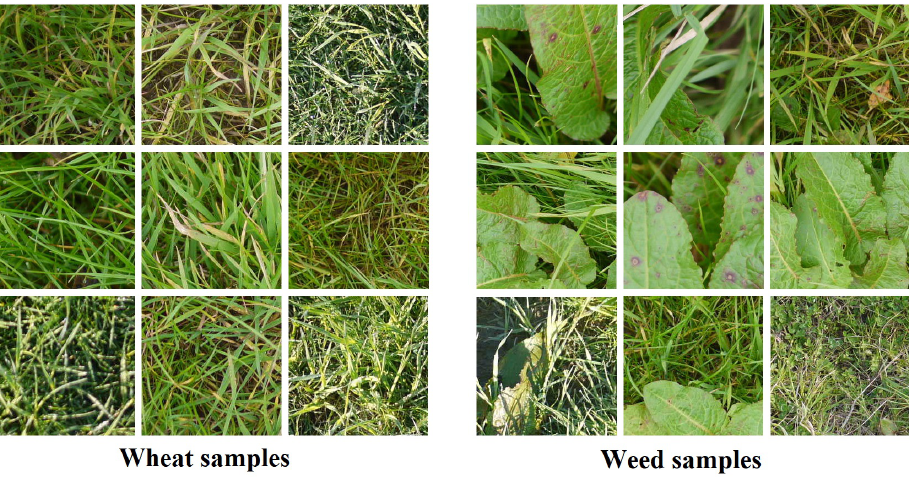
Figure 1. Sample wheat and weed images in the employed